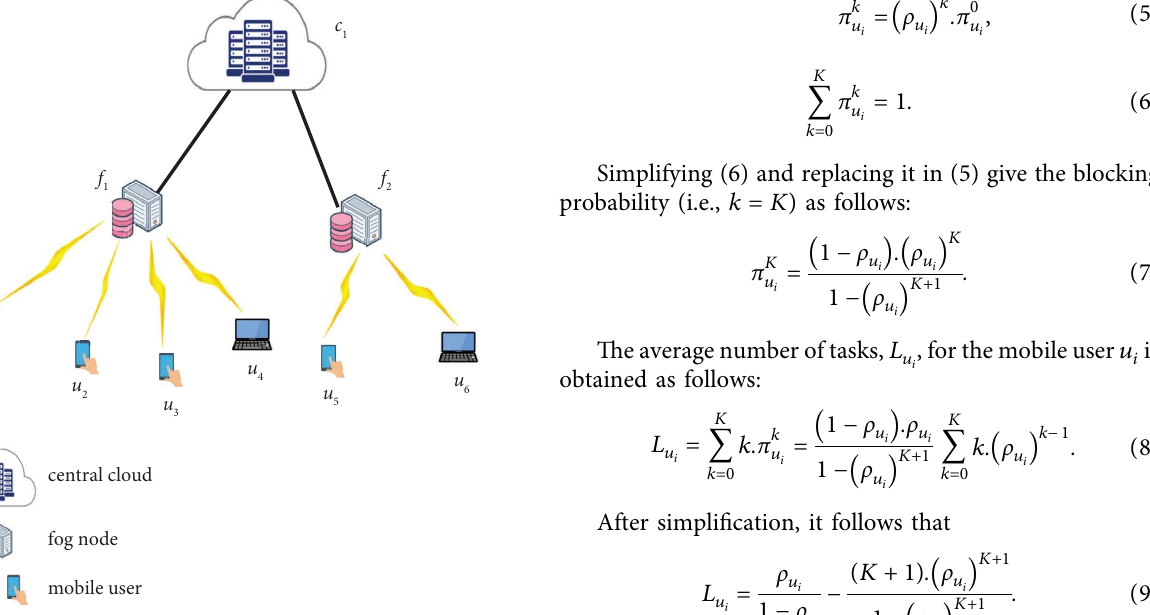
Figure 1: An illustration of the system